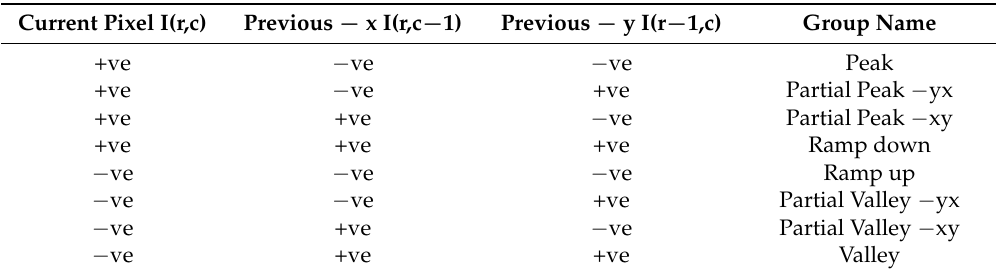
Algorithm 1. /* Pass original block of banknote, its first derivative, and second derivative images as argument*/